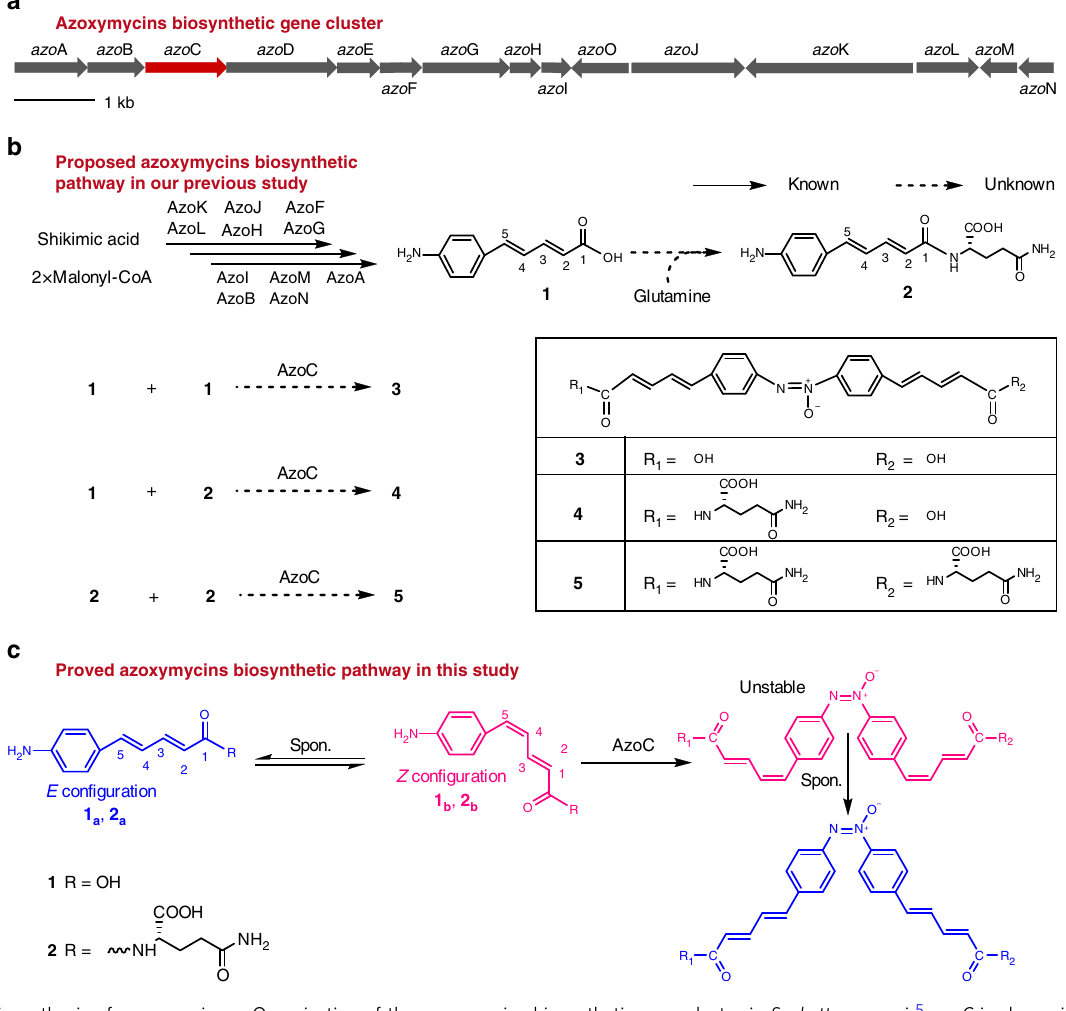
Fig. 1 The biosynthesis of azoxymycins. a Organization of the azoxymycins biosynthetic gene cluster in S. chattanoogensis 5 . azoC is shown in red. b Proposed biosynthetic pathway of azoxymycins in our previous study 5 . AzoB, AzoF, AzoG AzoH, AzoI, AzoJ, AzoK, AzoL, AzoM, and AzoN are responsible for the formation of 1 , and AzoC is presumed to catalyze the azoxy bond formation. c The amended biosynthetic pathway of azoxymycins from this study NATURE COMMUNICATIONS| (2019) 10:4420